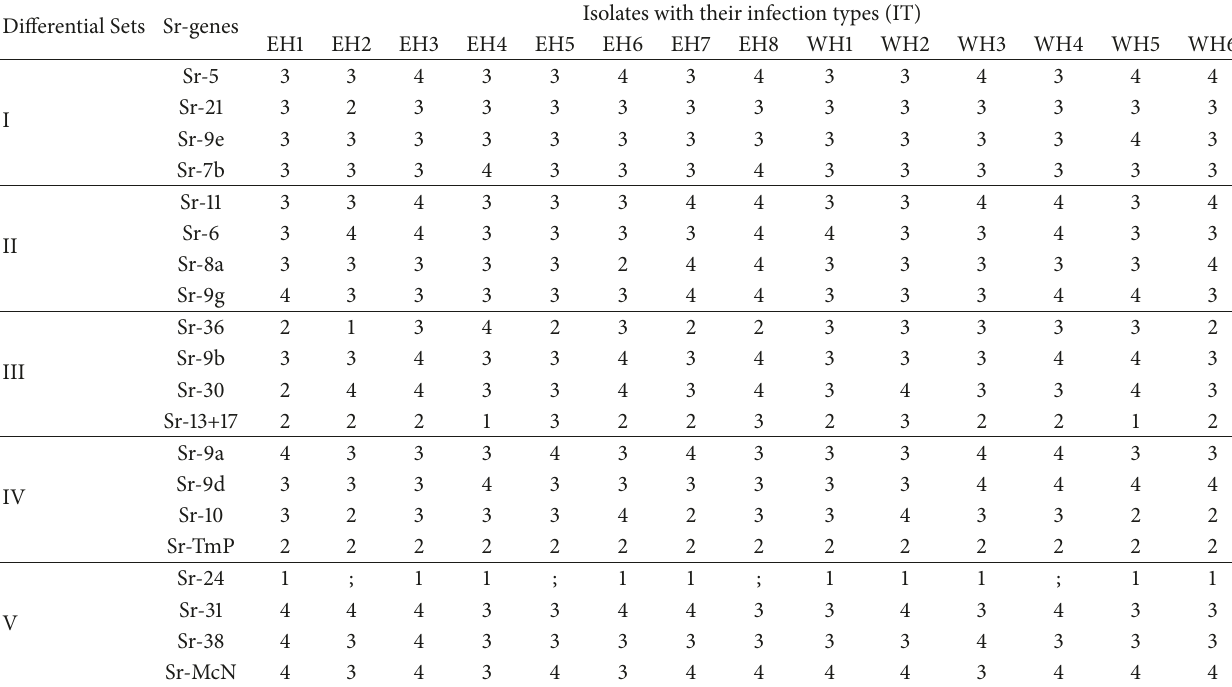
Table 3: The average infection types produced by East and West Hararghe isolates on differential lines for designation of races of Puccinia graminis f. sp. tritici .